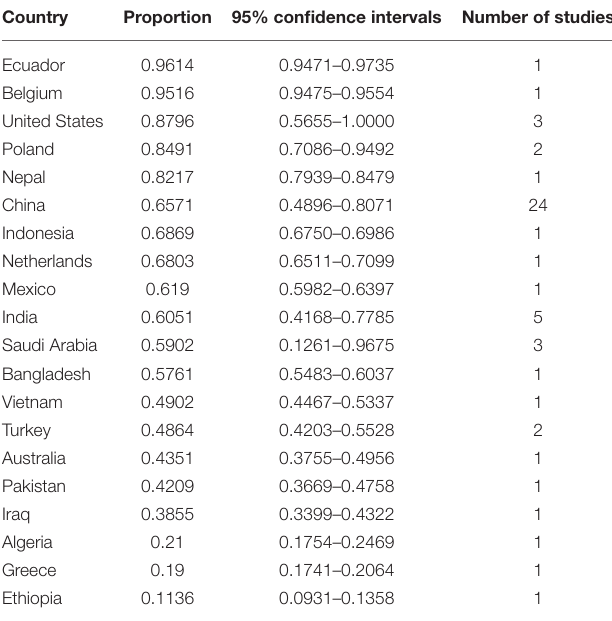
TABLE 2 | Estimated proportion of TCIM usage in each country.